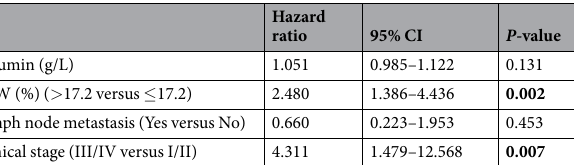
Table 4. Multivariate analysis of overall survival in melanoma patients. CI, confidence interval. Abbreviations: see to Tables 1 and